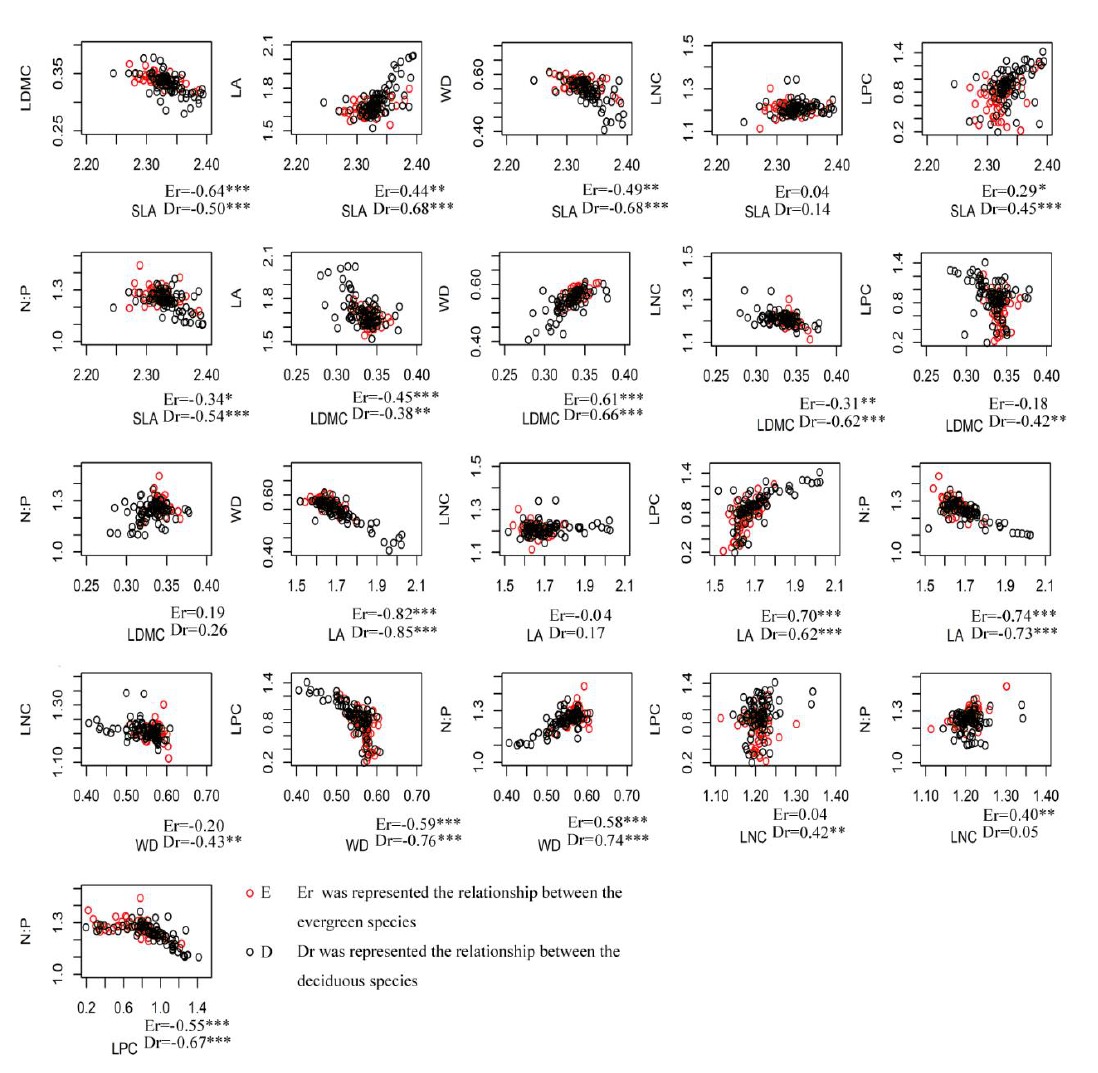
Figure 5. Scatterplots of species’ beta trait values for all pairwise combinations of evergreen and deciduous species for seven functional traits in a subtropical evergreen deciduous broadleaved mixed forest in Central China. (* p < 0.05; ** p < 0.01;*** p <